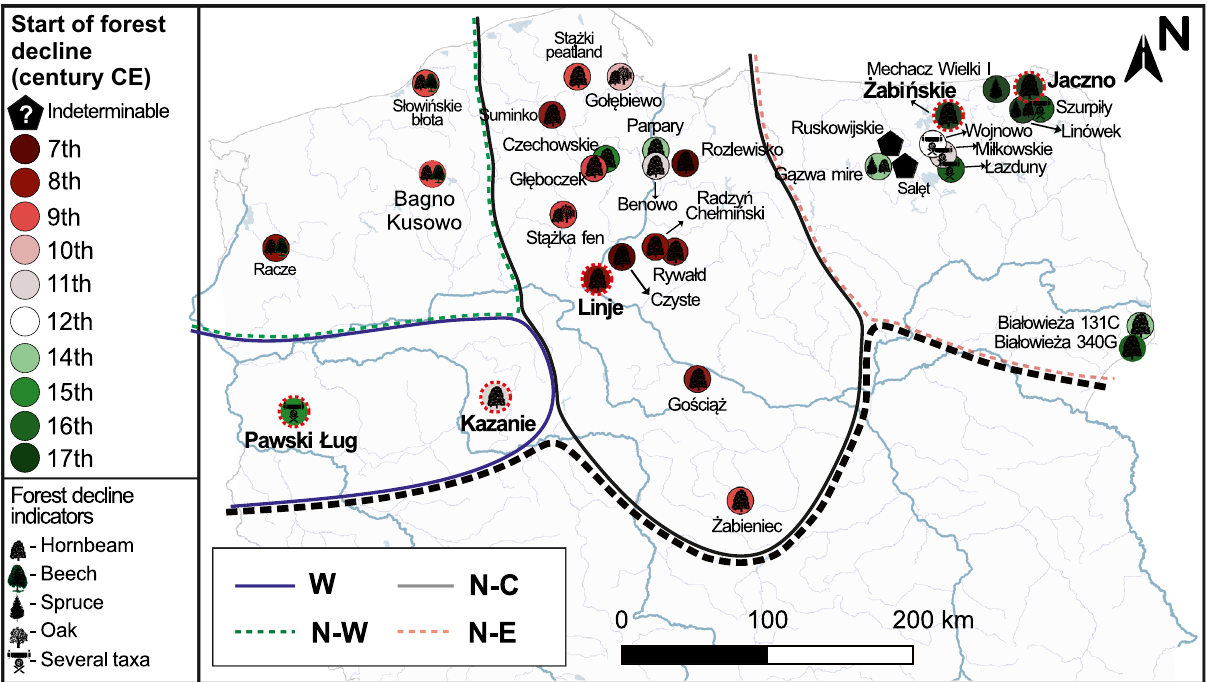
Figure 1. Geographical distribution of sites from the Polish Lowlands representing the beginning of forest decline after ca. 500 cal. CE and indicators of decline. The relevant publications are listed in Table 1. High- resolution data from the sites marked with red dashed circles are presented in Fig. 4. Abbreviations for simplified names of geographic regions used in the text: W—western, N–W—north-western, N–C—north-central, N–E— north-eastern. A black broken line indicates the southern limit of the study area. Map constructed by SC with QGIS 3.16.0 ’Hannover’ (https:// qgis. org/ en/ site/ index. html) and Corel Draw × 8 (https:// www. corel draw. com/